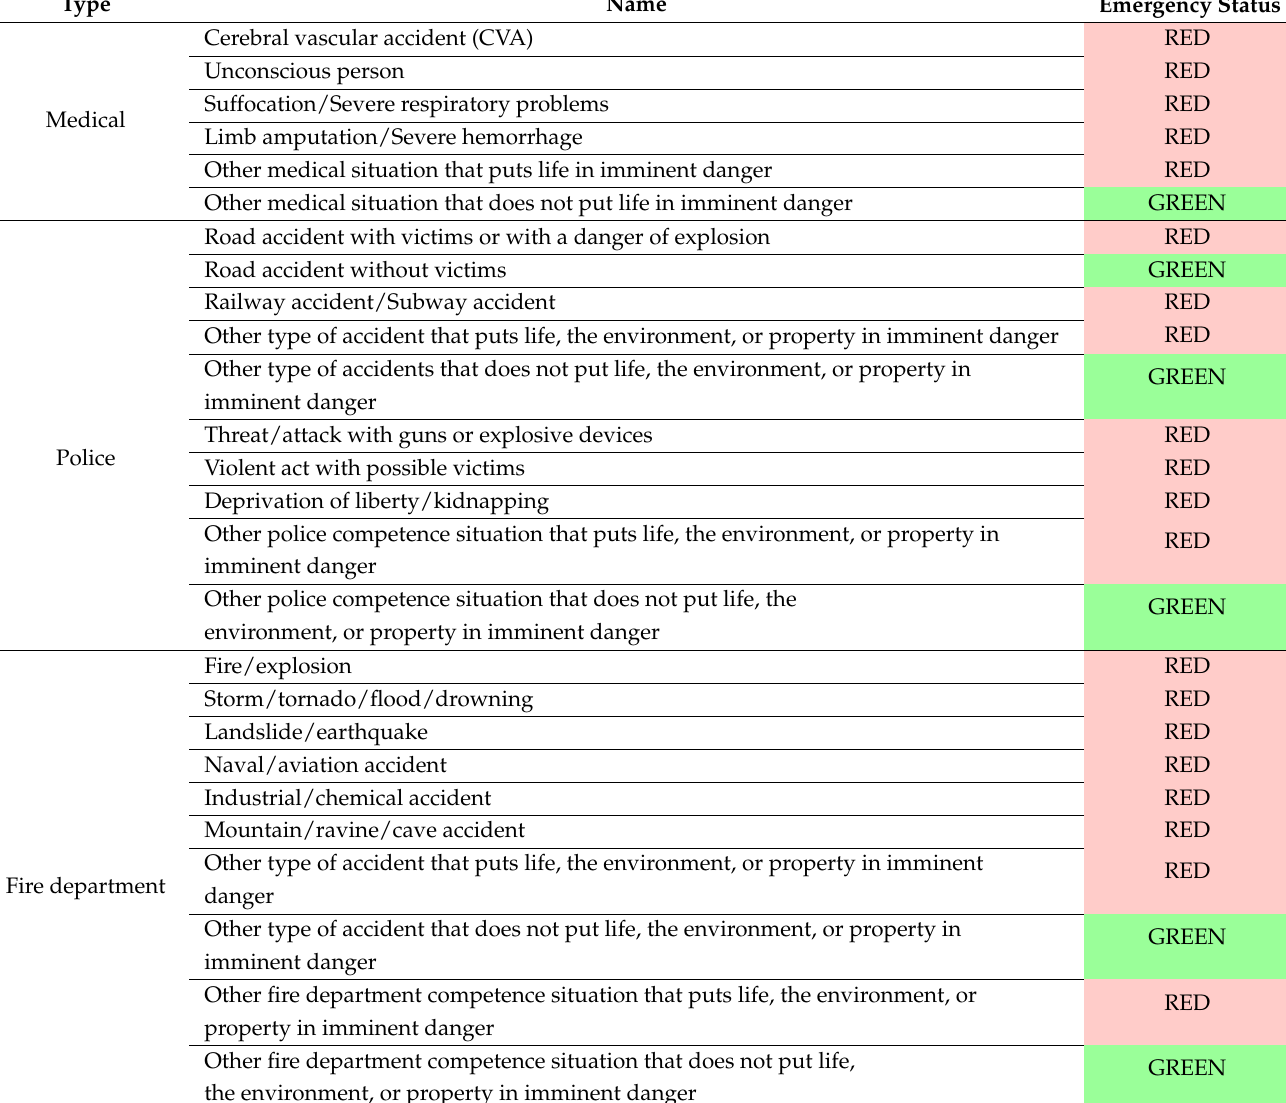
Table 2. Emergency statuses of the situations handled by the chatbot/IVR